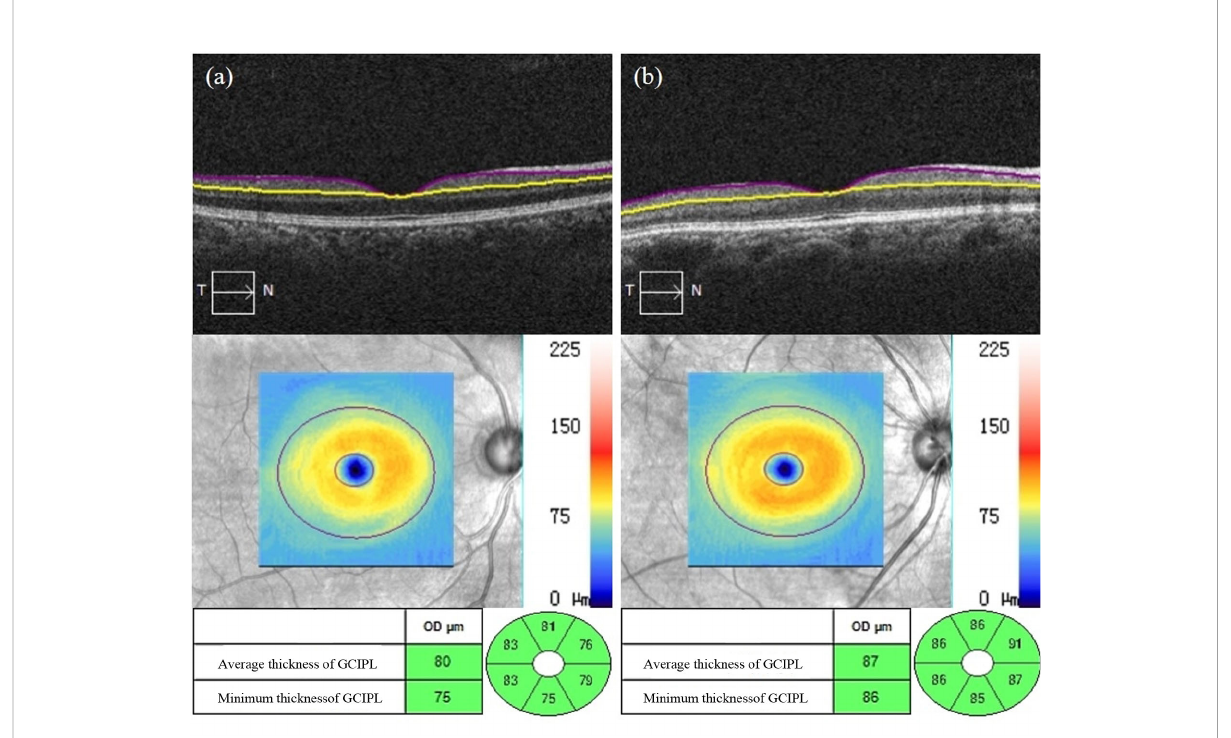
FIGURE 5 Representative OCT images of GCIPL thickness measurements in the macular area of the affected eyes in the NDR group and the tested eyes in the control group. (A) Results of the OCT macular area B scan, GCIPL thickness fi gure and GCIPL mean, minimum, and each quadrant thickness automatically measured by the system software of the right eye of a 50-year-old male NDR patient. (B) Results of the OCT macular area B scan, GCIPL thickness fi gure and GCIPL mean, minimum, and each quadrant thickness automatically measured by the system software of the right eye of a 67-year-old female